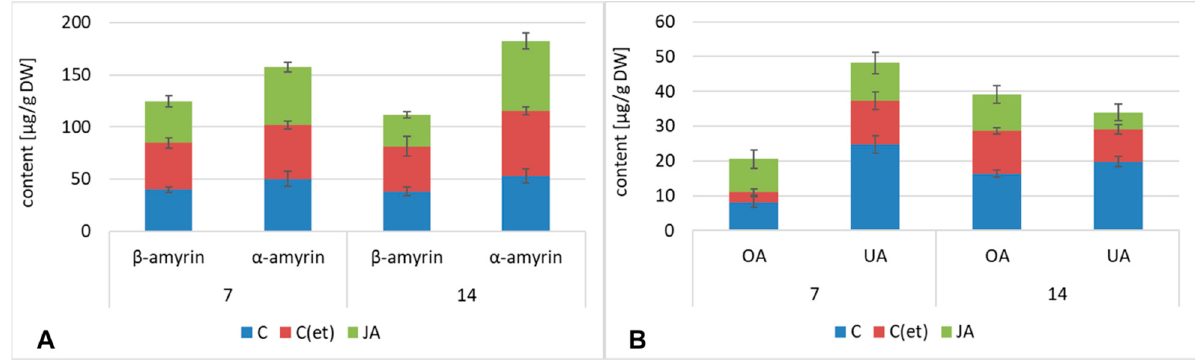
Figure 14. The content of neutral triterpenoids ( A ) and free acids ( B ) in C. officinalis shoots. C—control, C(et)—control samples treated with the adequate volume of 70% ethanol, JA—jasmonic acid-elicited samples. See detailed data and statistical significance in Table S21.